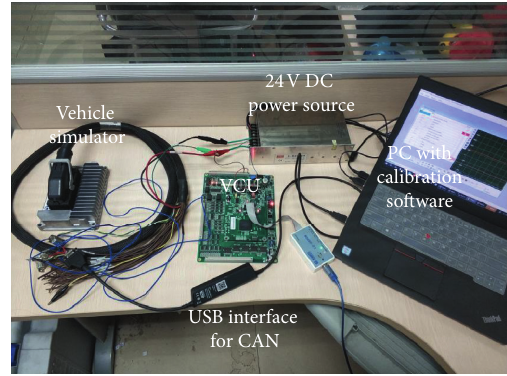
Figure 14: HIL test